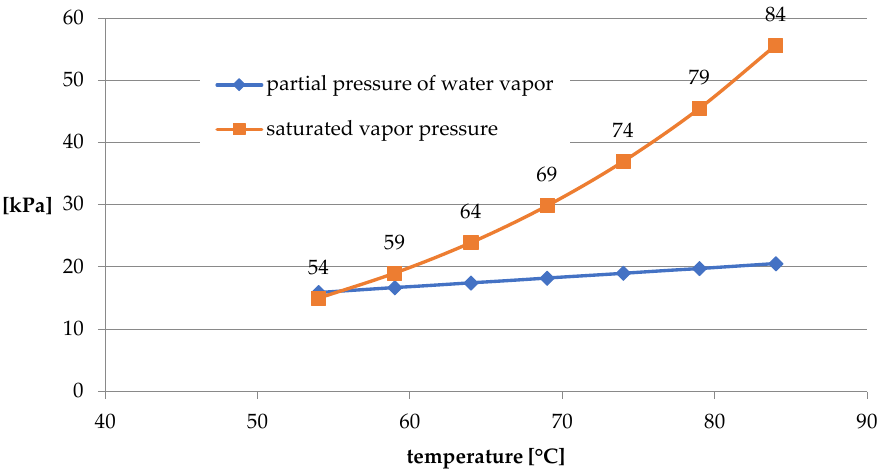
Figure 12. Partial pressure of water vapor in the working medium vs. saturated vapor pressure.